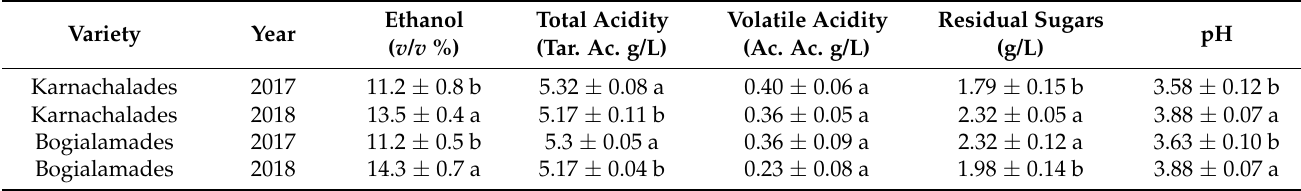
Table 4. Results from One–Way Analysis of Variance (ANOVA) with Tukey’s test, of the conventional wine analysis parameters (alcohol strength, pH, total acidity,) of “Karnachalades” and “Bogialamades” wines in two consecutive vintages.